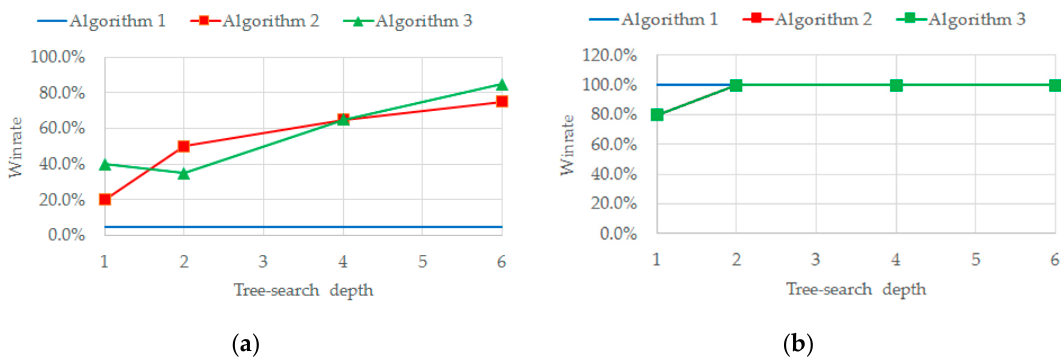
Figure 8. Winrates for the algorithms when the opening move is made by the human player ( a ) and the computer ( b ).